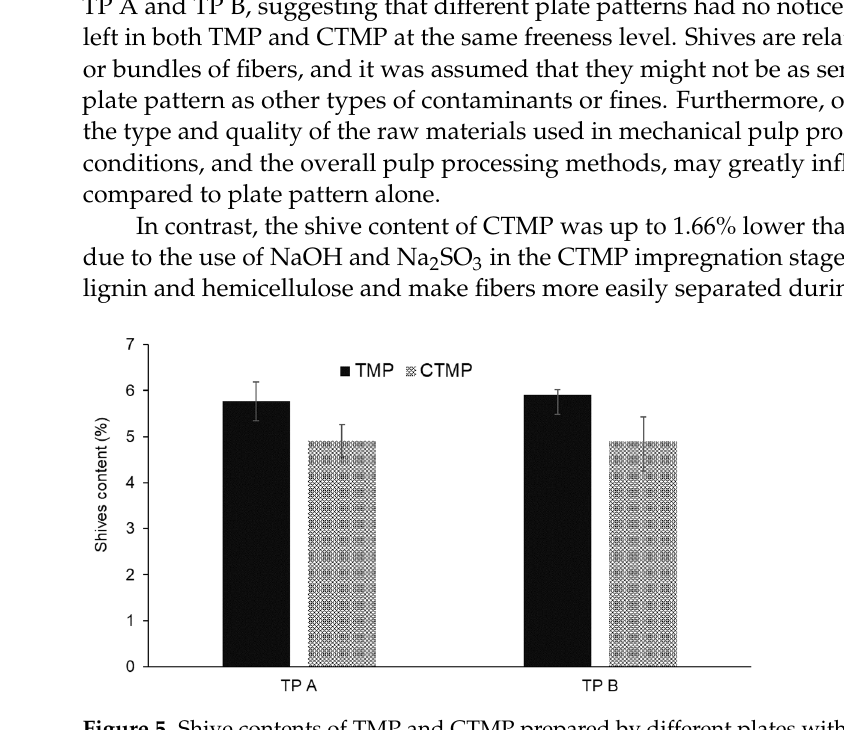
Figure 5. Shive contents of TMP and CTMP prepared by di ff erent plates with distinctive pa tt erns.